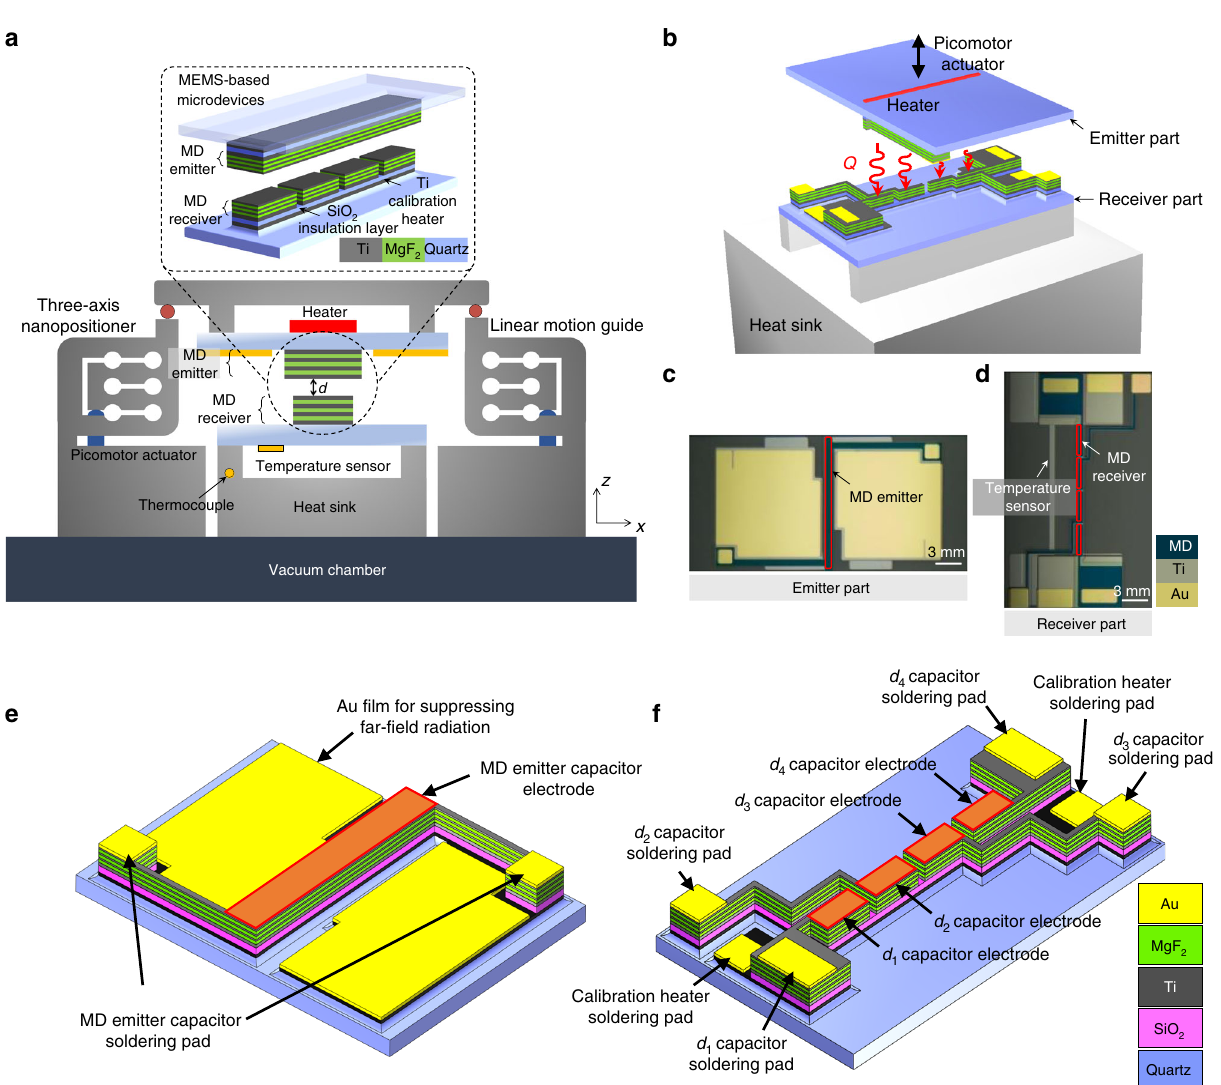
Fig. 1 Experimental setup for measuring near- fi eld thermal radiation between MD multilayers. a Schematic of an integrated platform consisting of the MEMS-based microdevices and the three-axis nanopositioner. b Three-dimensional schematic of the experimental setup. The position of the emitter part is controlled by the displacement of the picomotor actuators. The receiver part is fi xed on the heat sink. c Photo of emitter part taken by digital single-lens re fl ex (DSLR) camera. The width and length of the MD emitter are 720 μ m and 14.3 mm, respectively. The area excluding the MD emitter is coated with Au fi lm to suppress far- fi eld radiation. d DSLR image of the receiver part. The width of the MD receiver is 540 μ m. The length of one segment of the MD receiver is 3.44 mm. e Three-dimensional schematic of emitter part of MEMS-fabricated microdevice. MD-emitter-capacitor electrode, Au fi lm for suppressing far- fi eld radiation, and MD-emitter-capacitor-soldering pads are described. f As in e , except for the receiver part.